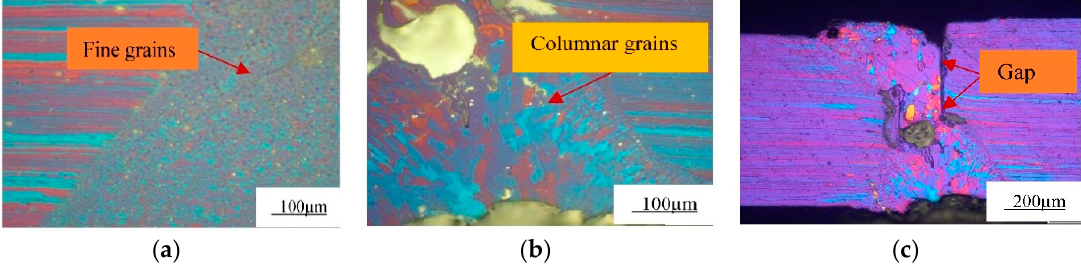
Figure 7. Microstructure of the welded joints: ( a ) with Al-5Ti-B; ( b ) with Al-5Mg; and ( c ) without filler metal .